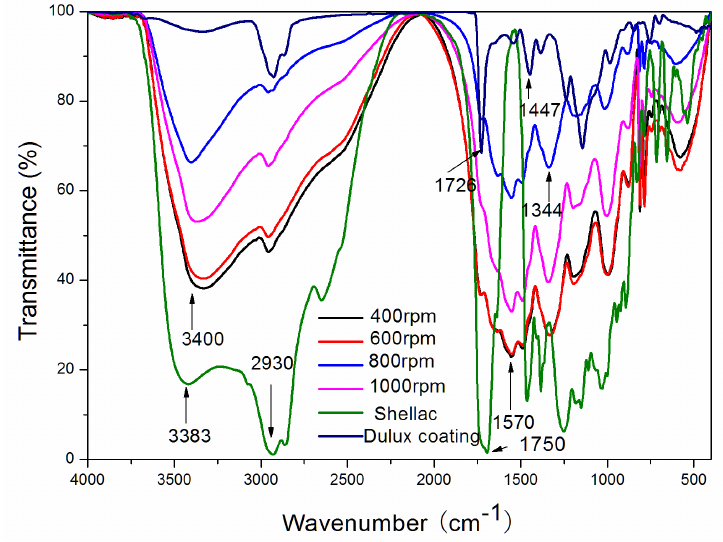
Figure 7. Single factor infrared spectroscopy.